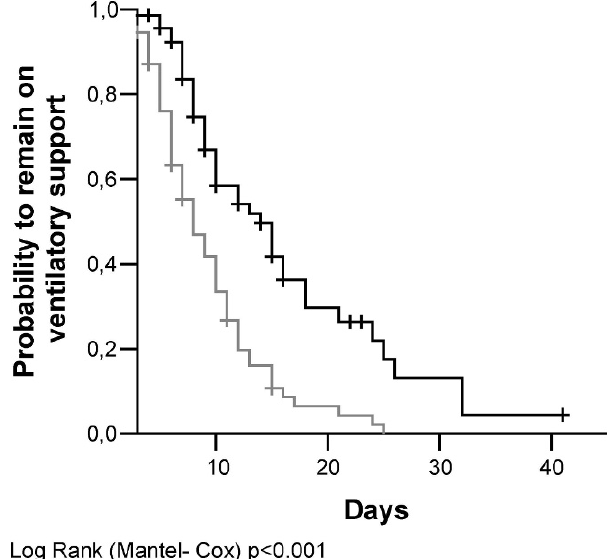
Figure 4 - Kaplan-Meier estimated cumulative probability of remaining on ventilatory support. The black line represents the control group; the gray line represents the intervention group. Tick marks represent censoring. The log-rank (Mantel-Cox) test was used to compare the curves; p , 0.001.